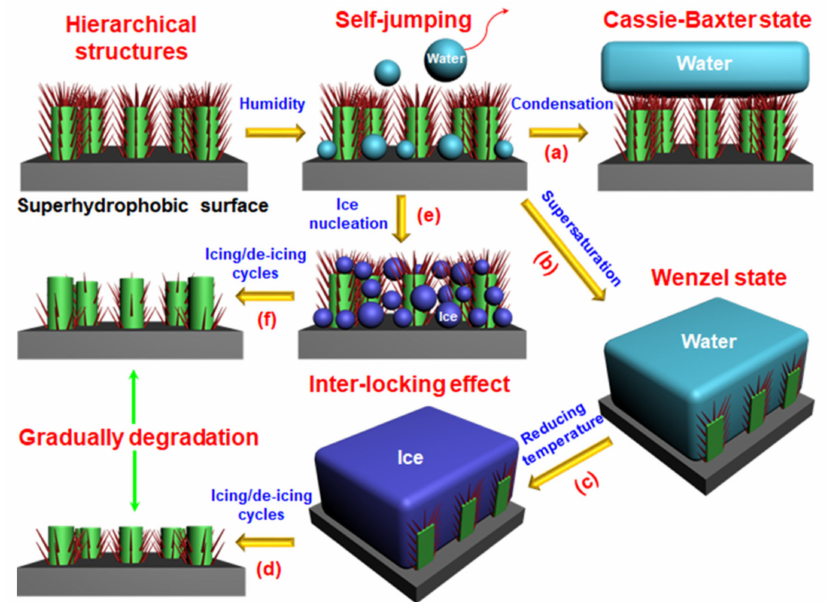
Figure 6. Overview of condensation on the superhydrophobic surface (SHS): ( a ) water remains at Cassie–Baxter state; ( b ) water completely wet hierarchical structures of SHS under supersaturation; ( c ) water in Wenzel state starts to freeze as temperature reduces, and then “Wenzel ice” forms; ( d ) de-icing of “Wenzel ice”, and hierarchical structures and surface chemistry gradually degrades during icing/de-icing cycles; ( e ) icing of small water droplets among hierarchical structures at low temperature; and ( f ) small ice covered SHS during icing/de-icing